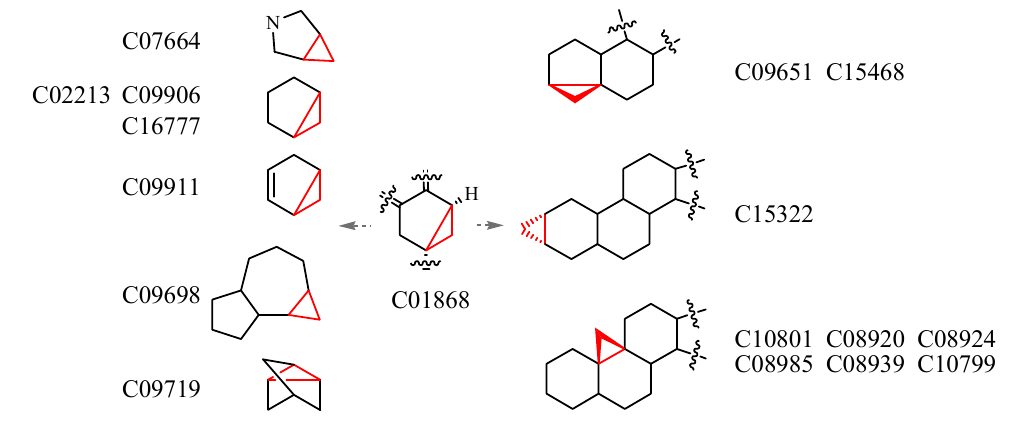
Figure 1. Structural diversity derived from the diverse framework (partial structure of each molecule).